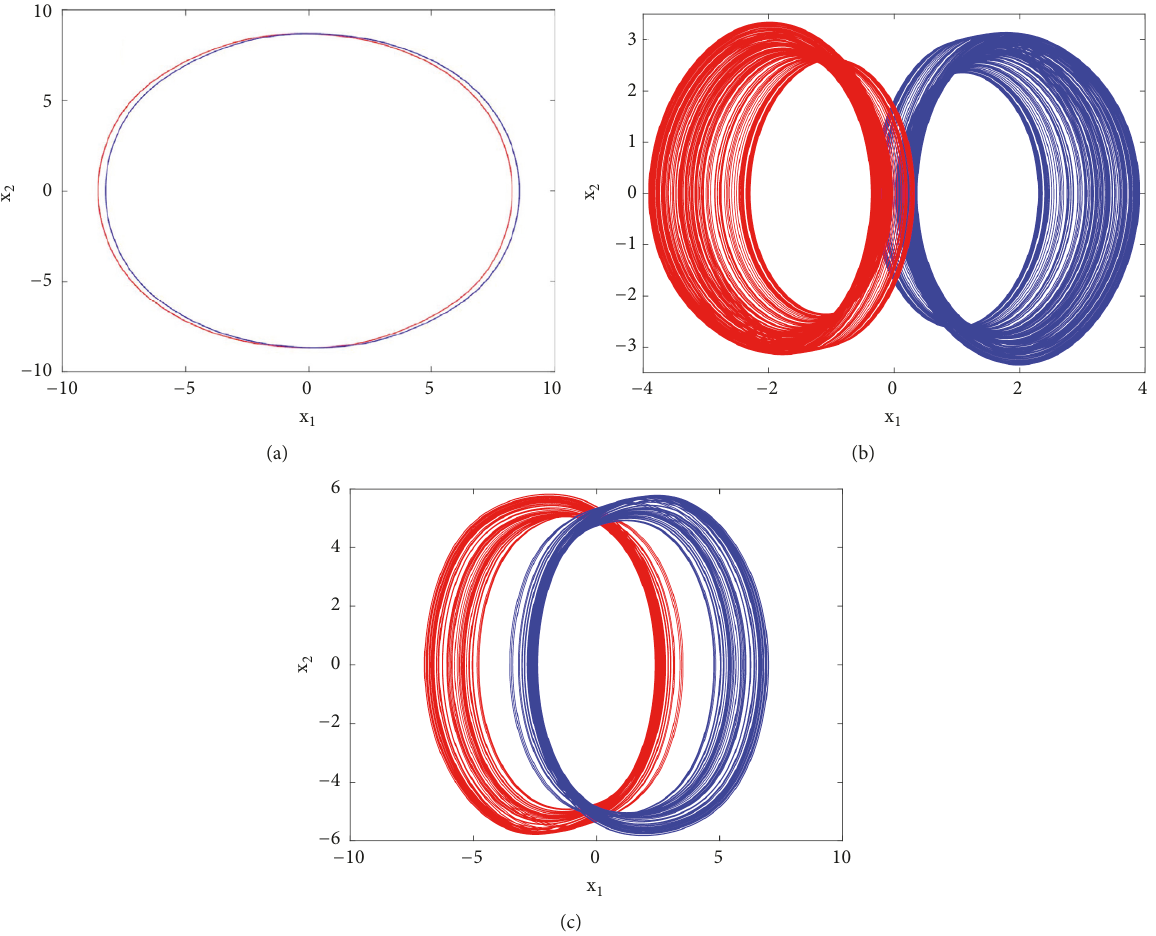
Figure 11: Two-dimensional projections (x 1 -x 2 ) of six coexisting attractors for a 2 = 2.8 (two pairs of chaotic attractors and a pair of period-1 limit cycle) with the rest of system’s parameters as follows: b = a 1 = 3, a 0 = 1.75, a 3 = 1, a 4 = 0.0054. Initial states are given in Table 1.